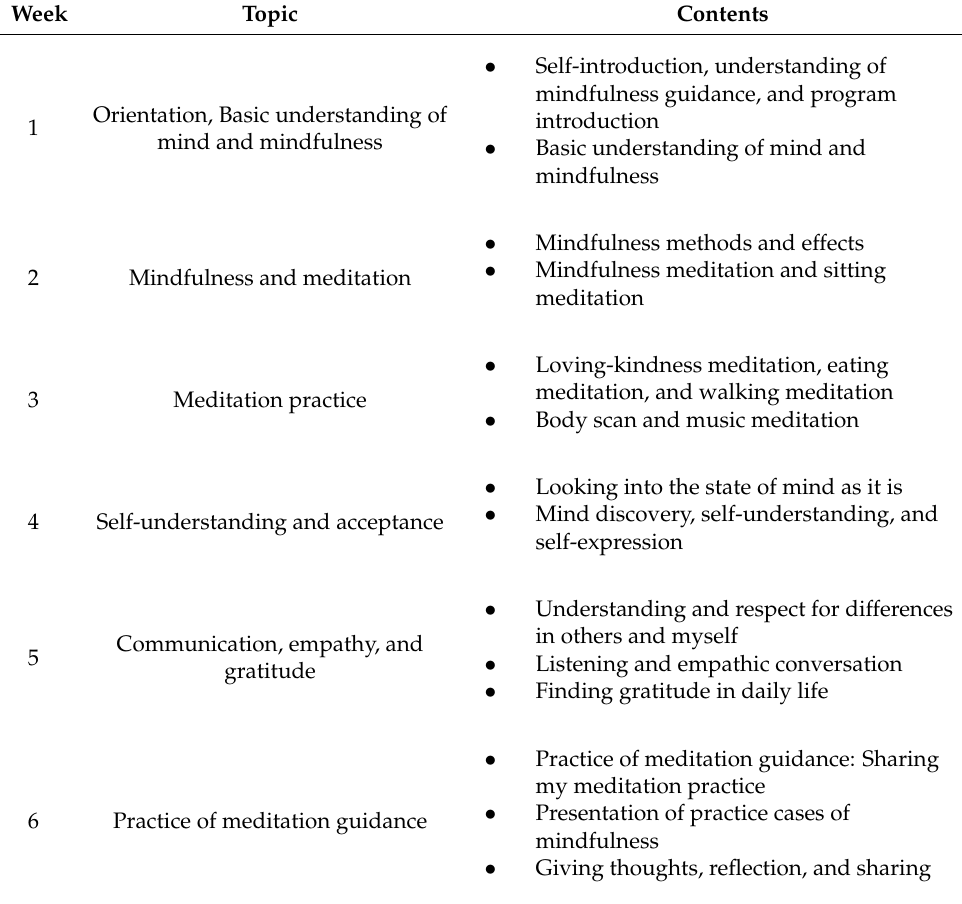
Table 1. The Contents of the Six-Week